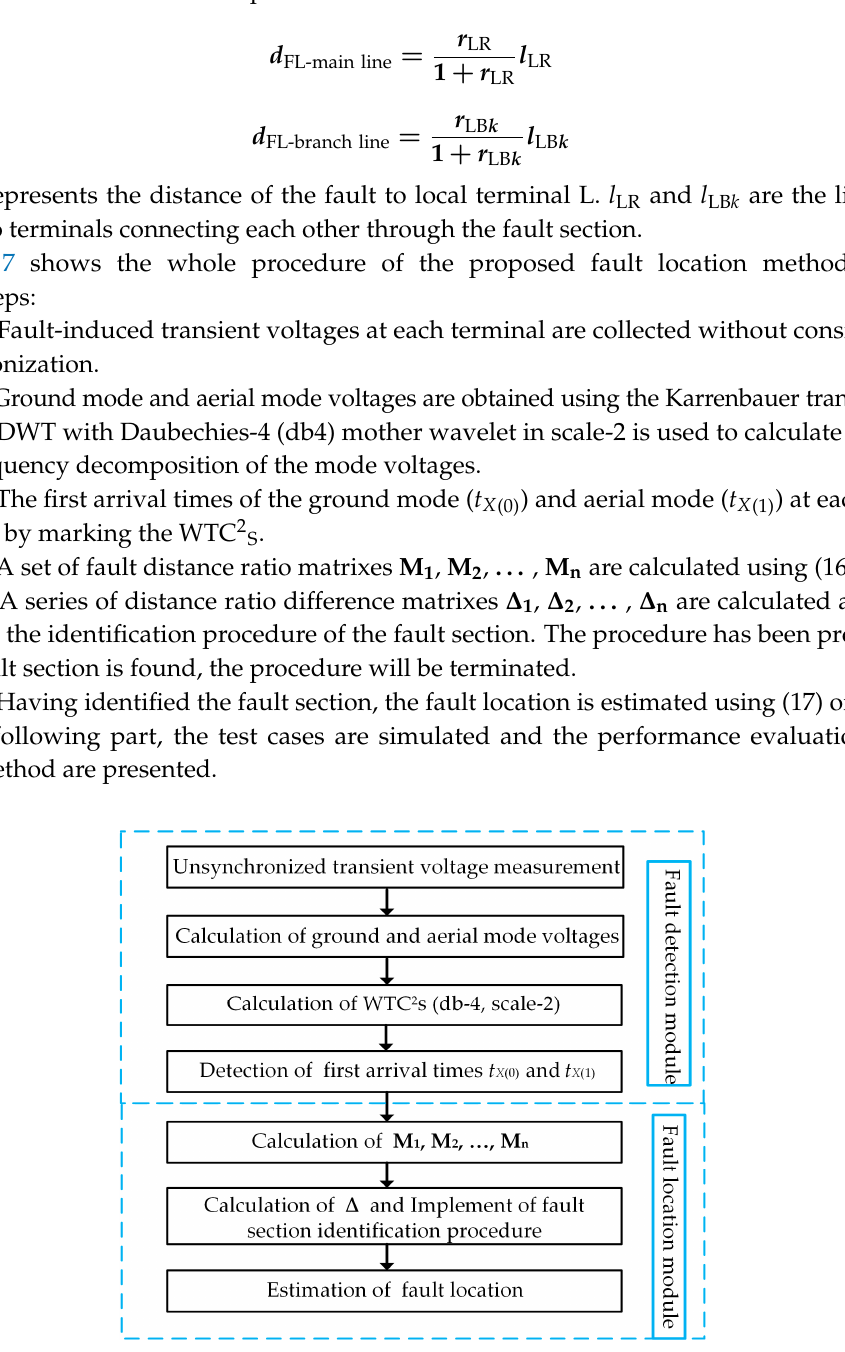
Figure 7. Flowchart of the proposed fault location method. WTC 2S —wavelet transformation coefficient squared.